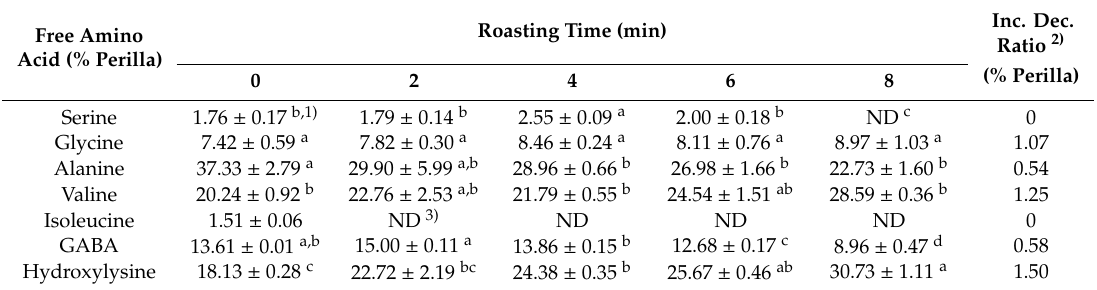
Table 4. Free amino acids in P. frutescens Britton var. acuta Kudo during the roasting. Free Amino Acid (%